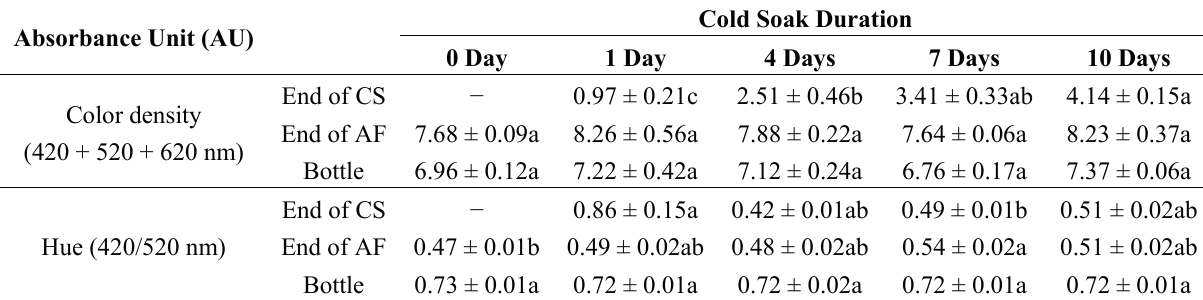
Figure 1. Color density evolution at different CS durations during CS and active fermentation as determined by UV-vis (n = 3). The end of CS for 1, 4, 7, and 10 days of CS treatment are marked as a dashed line at 39, 111, 183, and 255 h, respectively. Table 2. Color density and hue of wines made with different CS durations at the end of CS, the end of alcoholic fermentation (AF), and in bottled